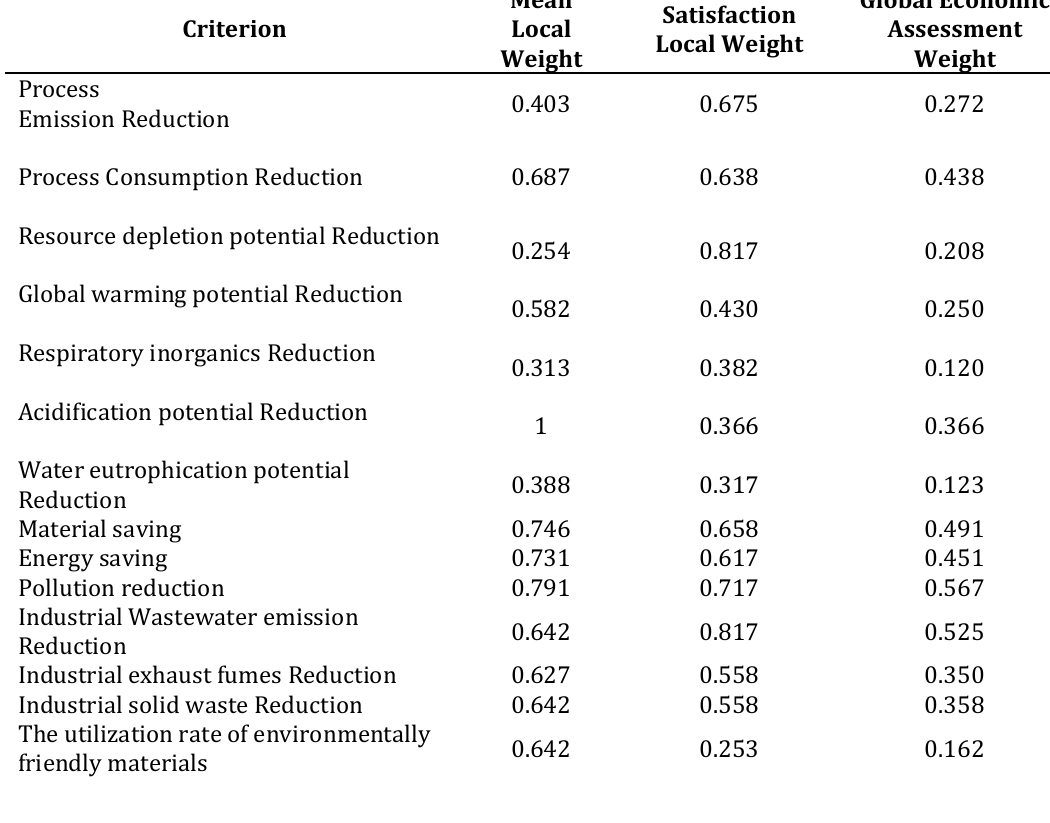
Table 4: Index weight and global weights of environment sub-sustainability assessment, micro-scale literature based